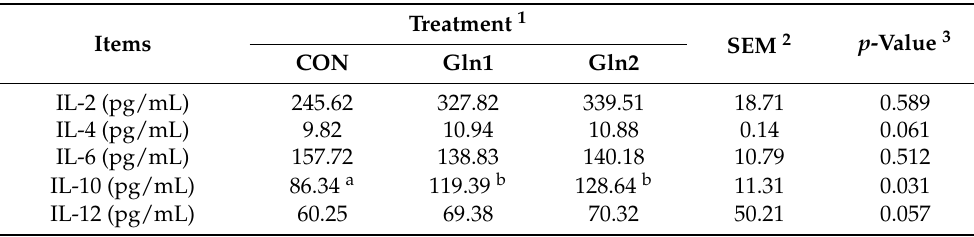
Table 5. Effects of adding Gln to high concentrate on Serum Cytokines and Immunoglobulins of